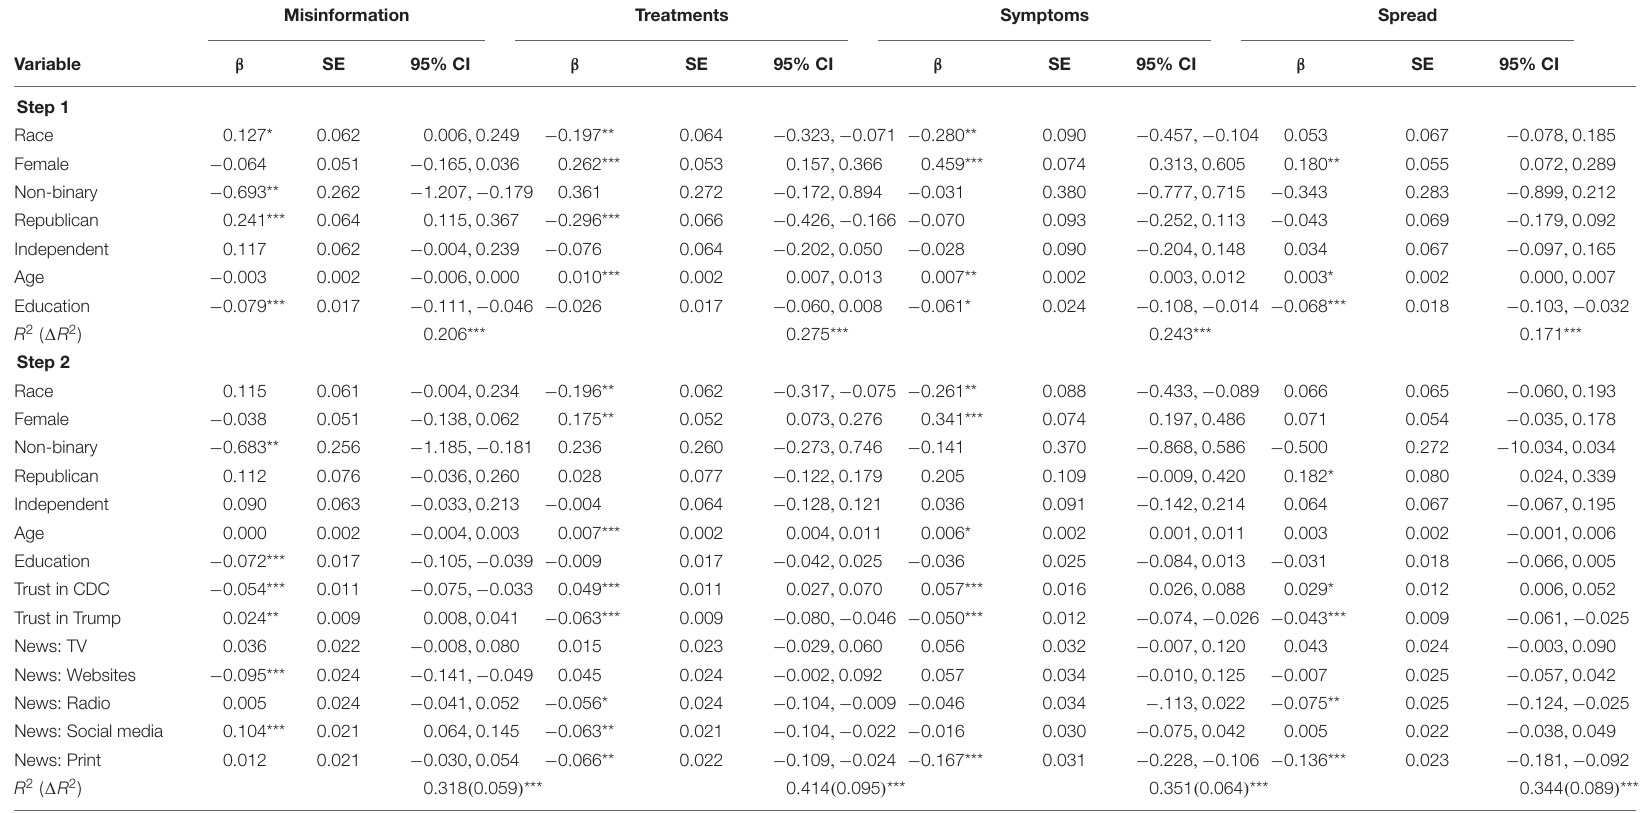
TABLE 2 | Regression analyses predicting knowledge about